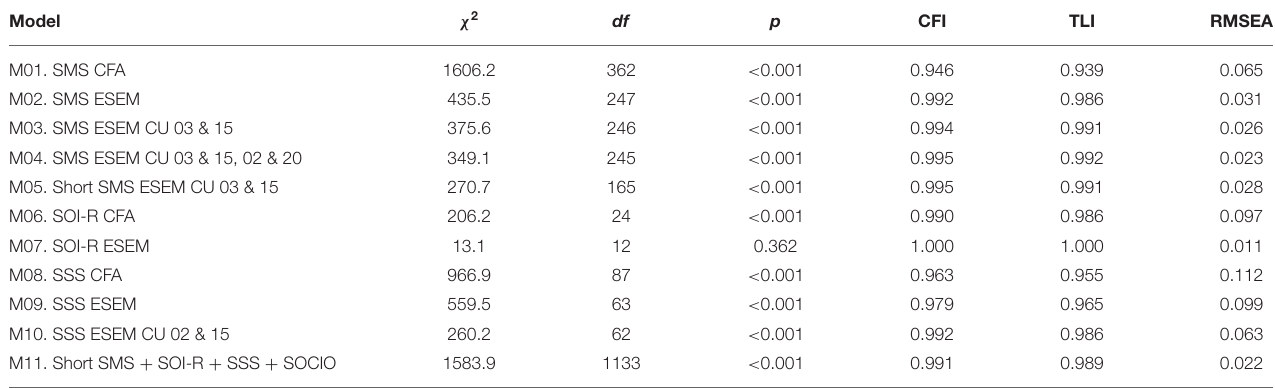
TABLE 1 | Goodness -of- fit indices for the different models.